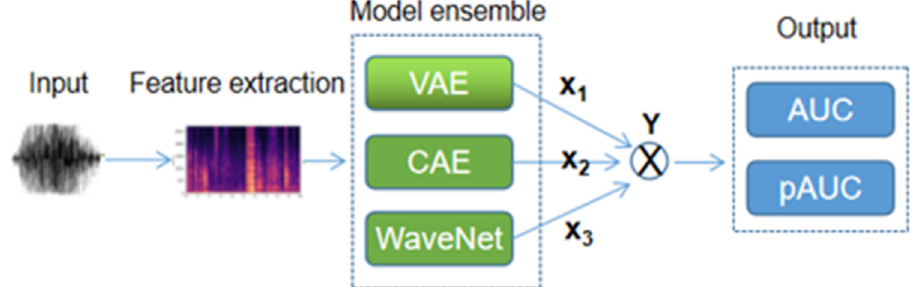
Fig. 4. Log-Mel is used for data feature extraction to train VAE, CAE and WaveNet network respectively. The training set is used to collect the output results, and the voting weights of the three networks are determined by regression analysis.